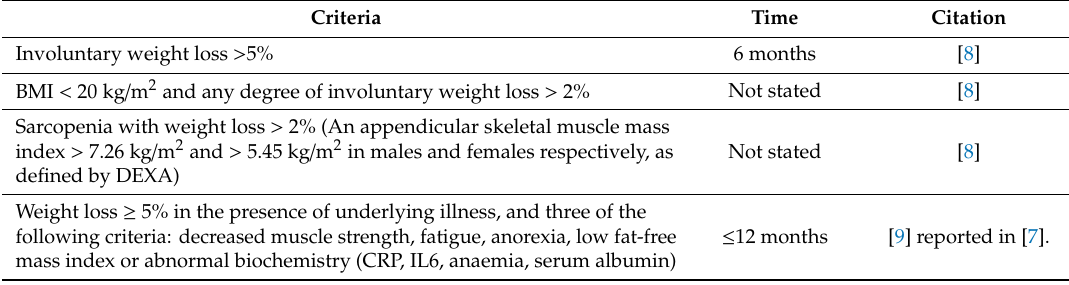
Table 1. Criteria used to define cancer